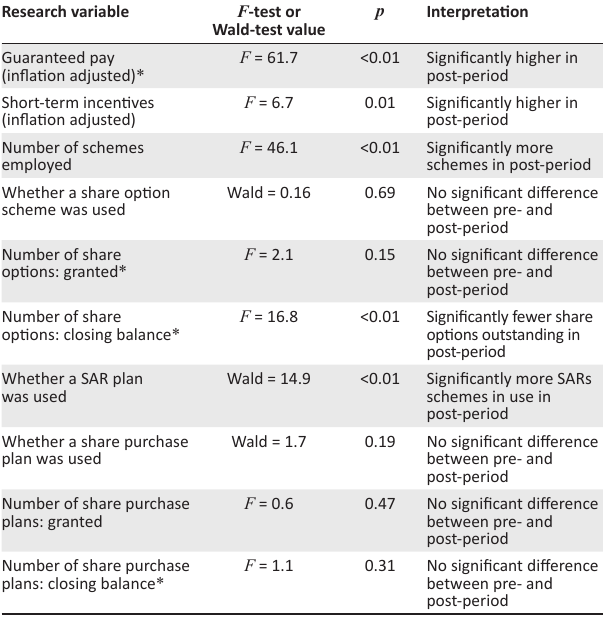
TABLE 3: Differences between the pre-International Financial Reporting Standard 2 and post-International Financial Reporting Standard 2